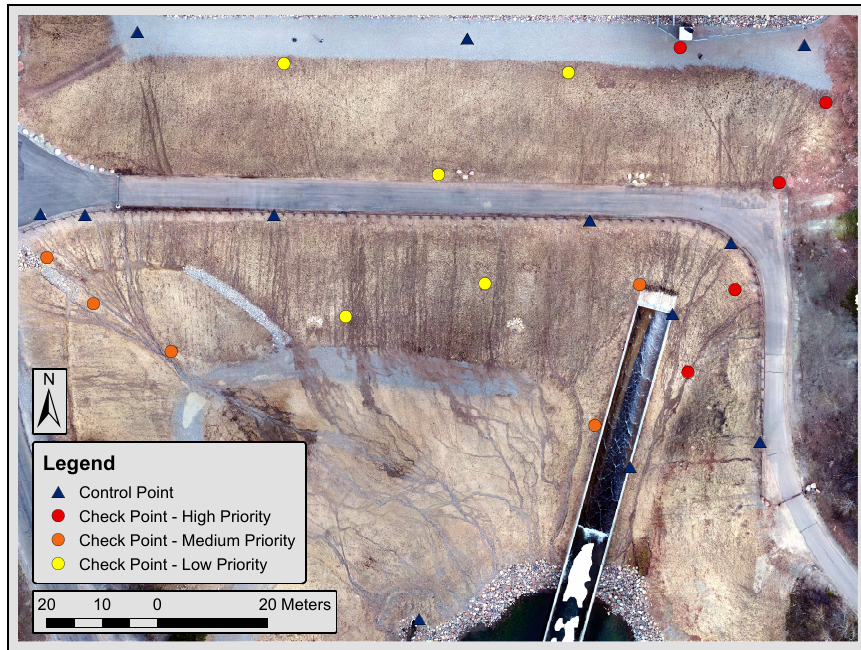
Figure 6. Control and check point locations on the face of Tibble Fork Dam.